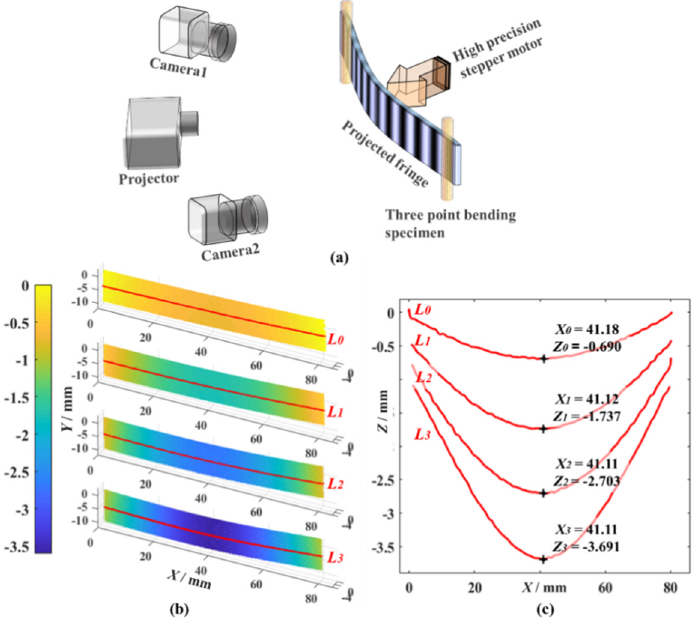
Figure 9. The three-point bending experiment and the 3D-SM measurement results. ( a ) Schematic diagram of the experimental device, ( b ) 3D shape of three-point bending specimens under different loads, ( c ) The shape of the specimen’s centerline.